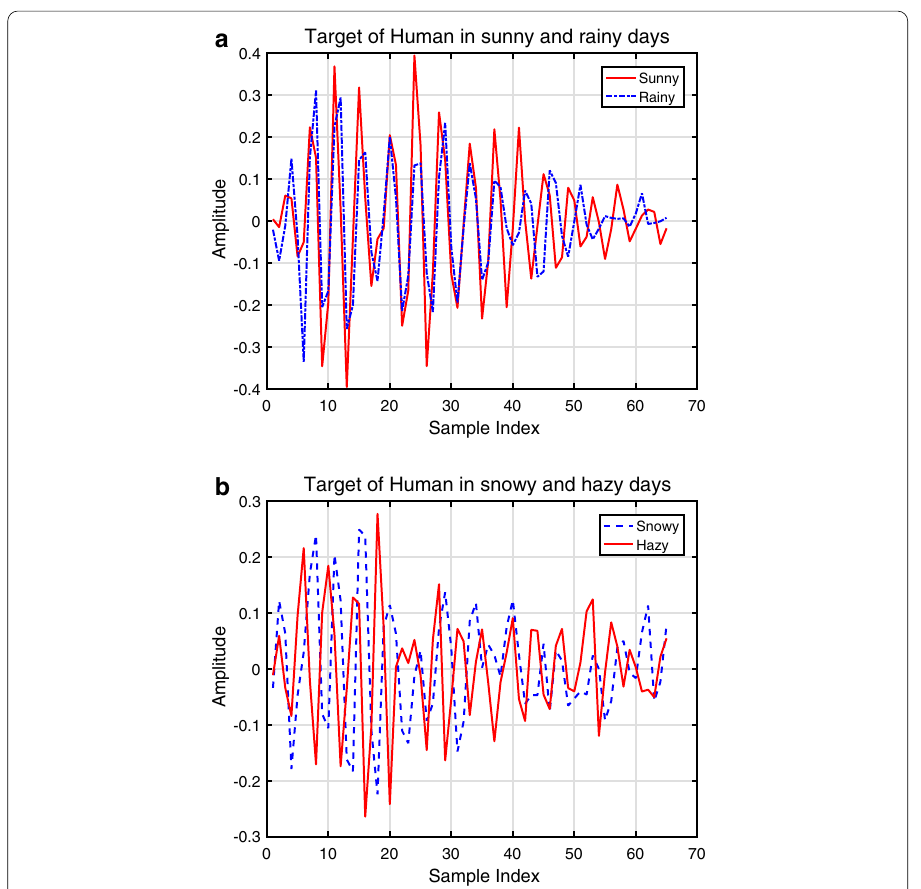
Fig. 6 Received UWB signals of human in different weather conditions after